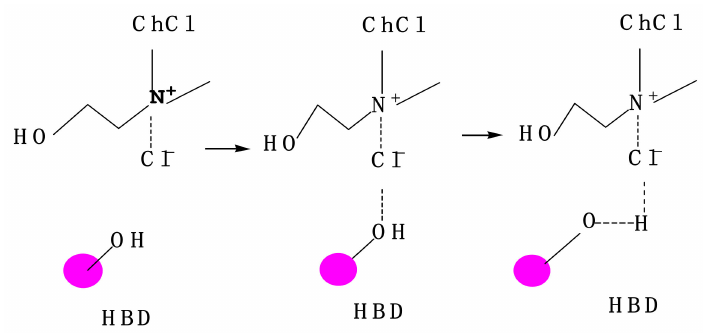
Figure 8. Synthetic route of ChCl / HBD